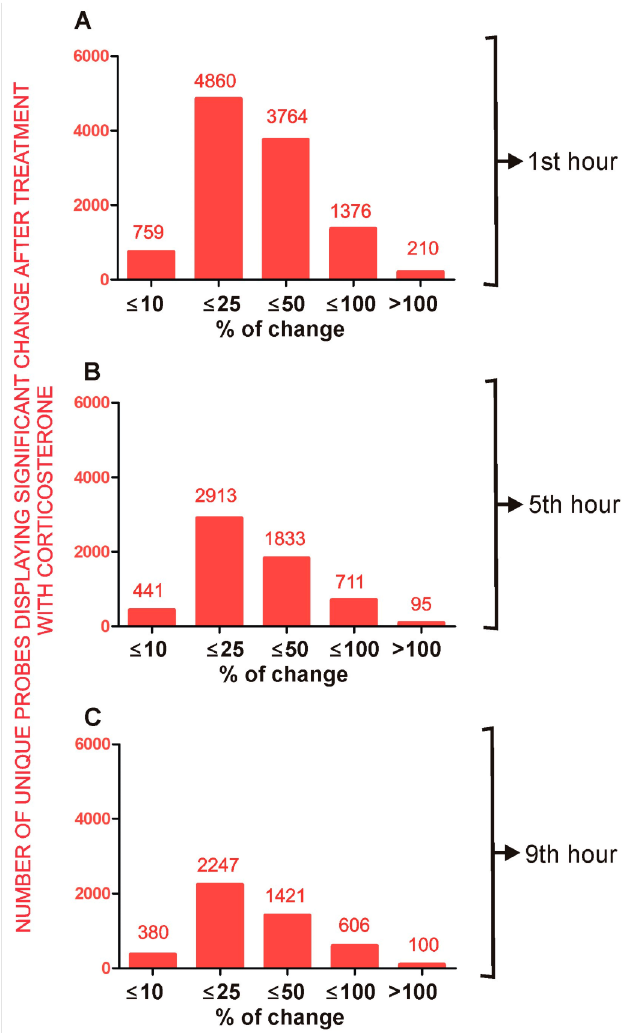
Figure 8. General characteristics of primary effects of corticosterone that are significant at least during the first hour of the resting period. ( A )—number of unique probes that indicated significant differences during the first hour of the resting period. ( B )—number of unique probes that indicated significant differences during the first and the fifth hour of the resting period. ( C )—number of unique probes that indicated significant differences during the first, fifth and ninth hour of the resting period. Numbers above the bars indicate an exact number of unique probes showing significant differences between groups separately for categories based on the magnitude of altered expression. All data are available in File